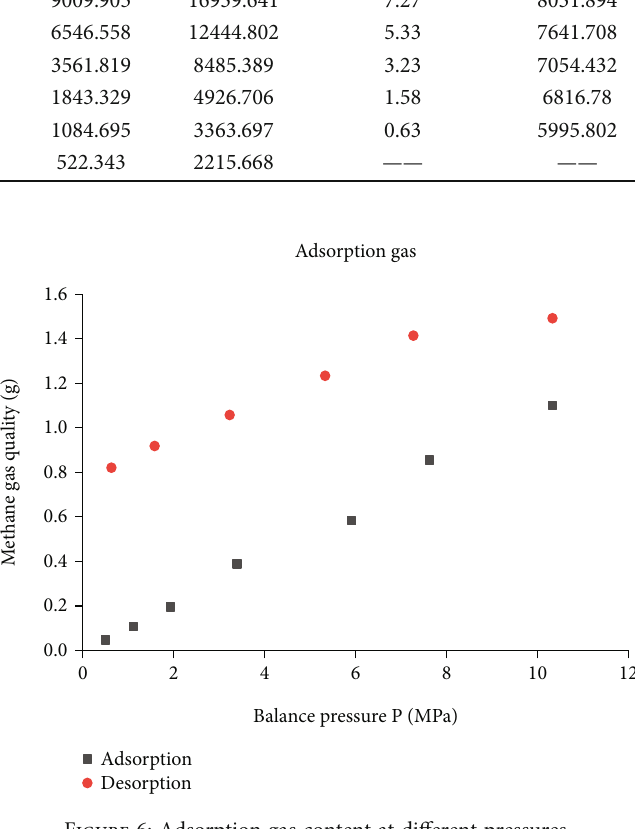
Figure 6: Adsorption gas content at di ff erent